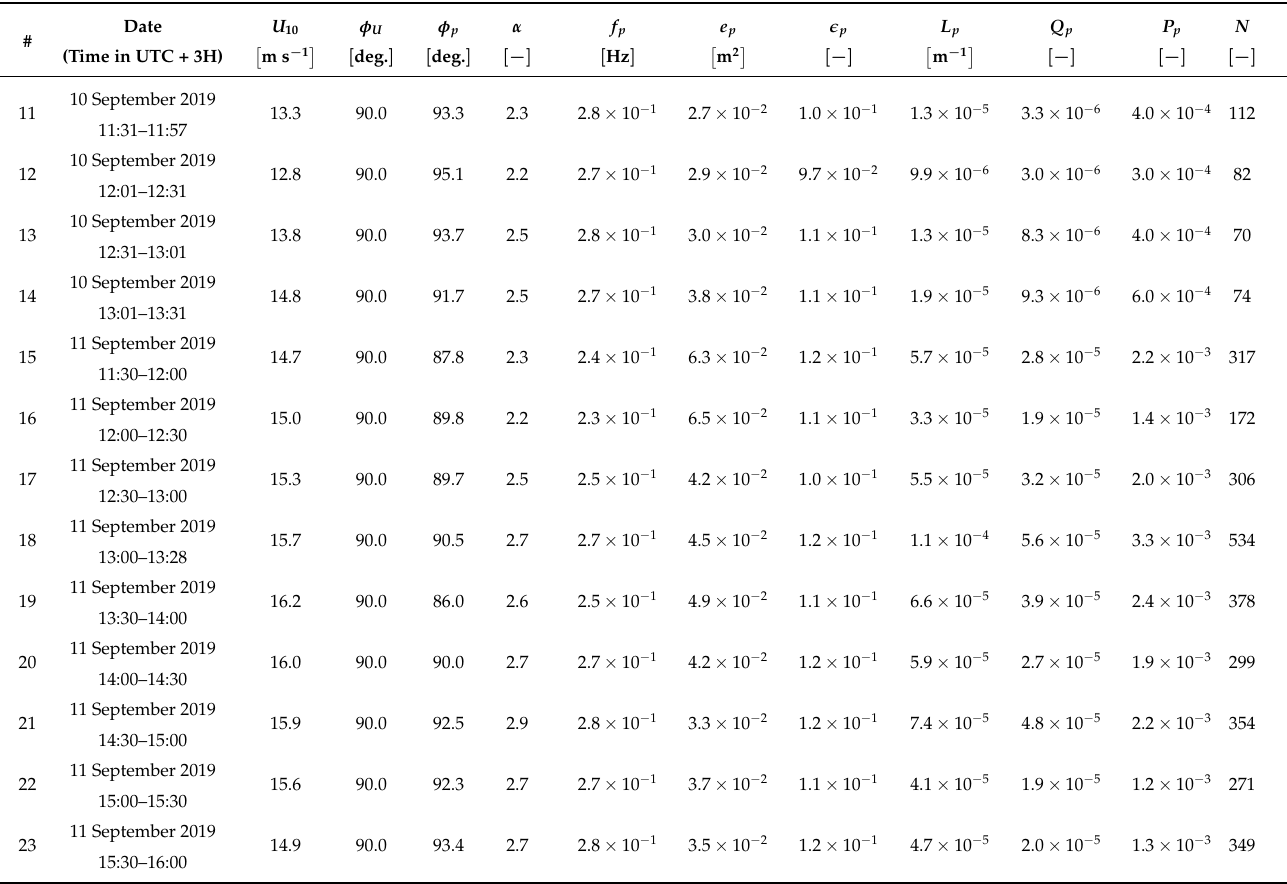
* The seas with single-peak wave spectra. The energy and steepness of the rest of the table’s entries were estimated after the one-dimensional partitioning was applied (Appendix A). Table 2. The same as Table 1, but for dominant wind-waves in the offshore-wind